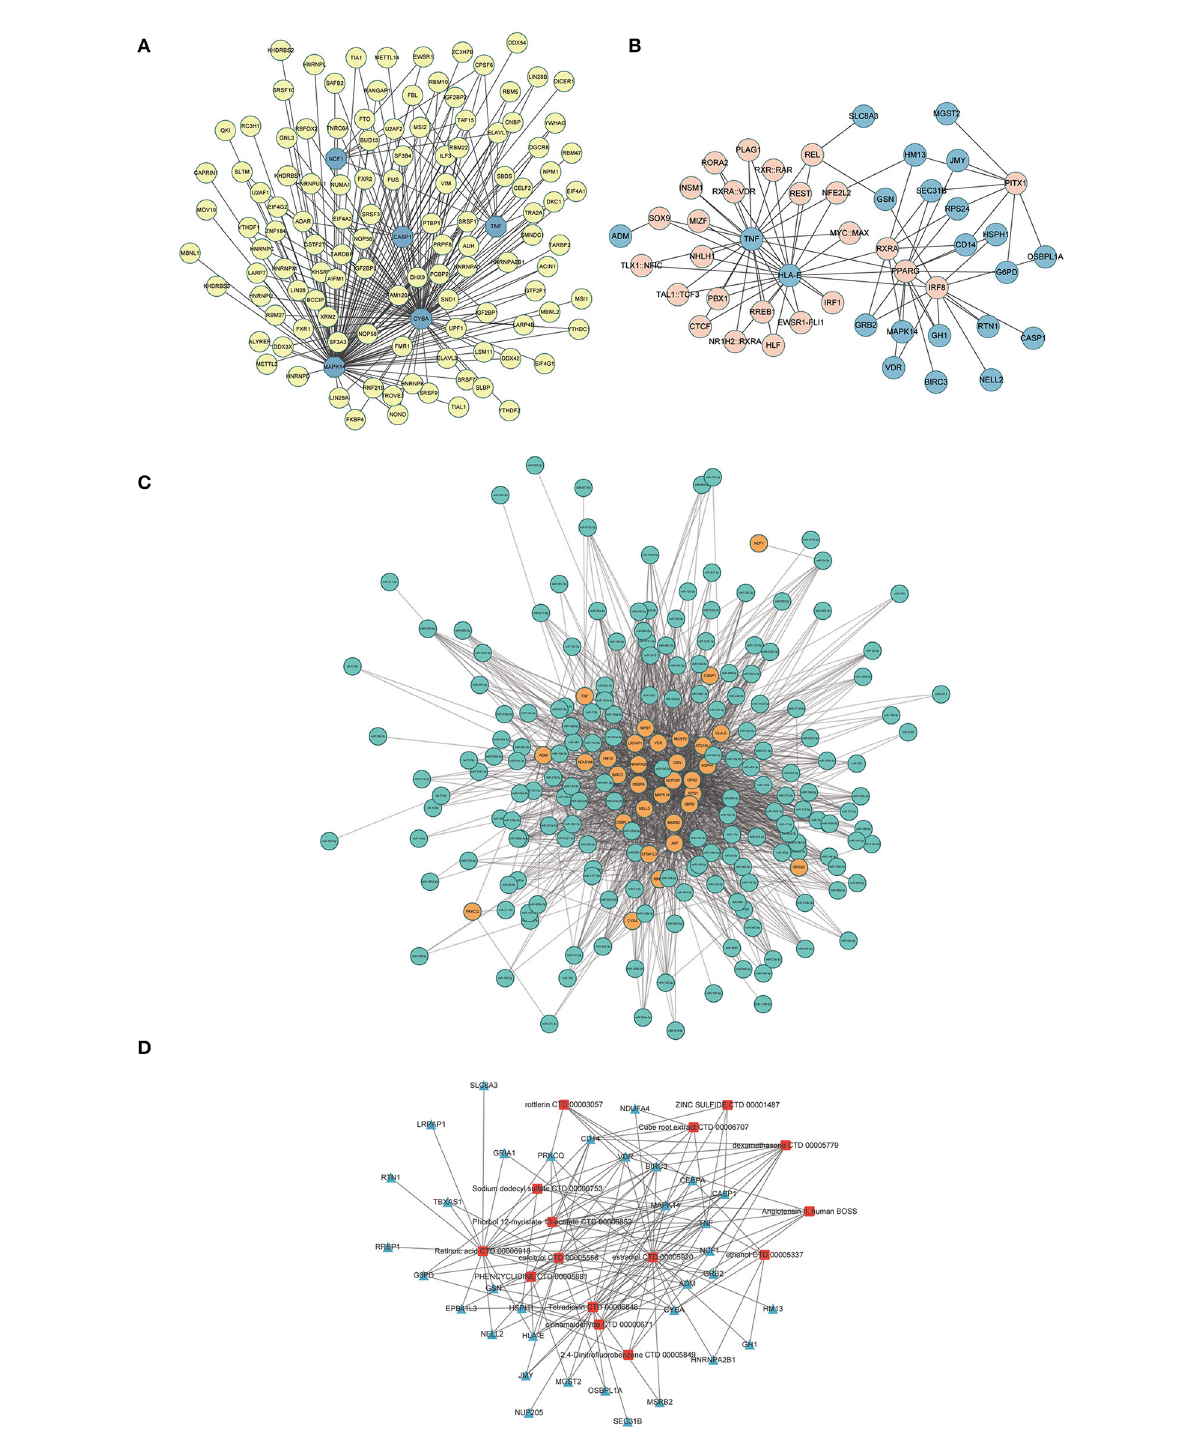
FIGURE10 Interaction network analysis of endoplasmic reticulum stress-related differentially expressed genes (ERSR-DEGs). (A) In the RBPs-hub genes regulatory network, where the highlighted blue circle nodes represent the hub genes, and the yellow nodes represent RBPs. (B) In the TF-gene regulatory network of ERSR-DEGs, the highlighted blue circle nodes represent ERSR-DEGs, and pink nodes represent TF genes. (C) In the miRNA -gene regulatory network of ERSR-DEGs, the highlighted orange circle nodes represent the ERSR-DEGs, and the green nodes represent miRNA genes. (D) In the Drug-gene interaction network of ERSR-DEGs, where the highlighted blue squares represent the ERSR-DEGs, and the red squares represent the related